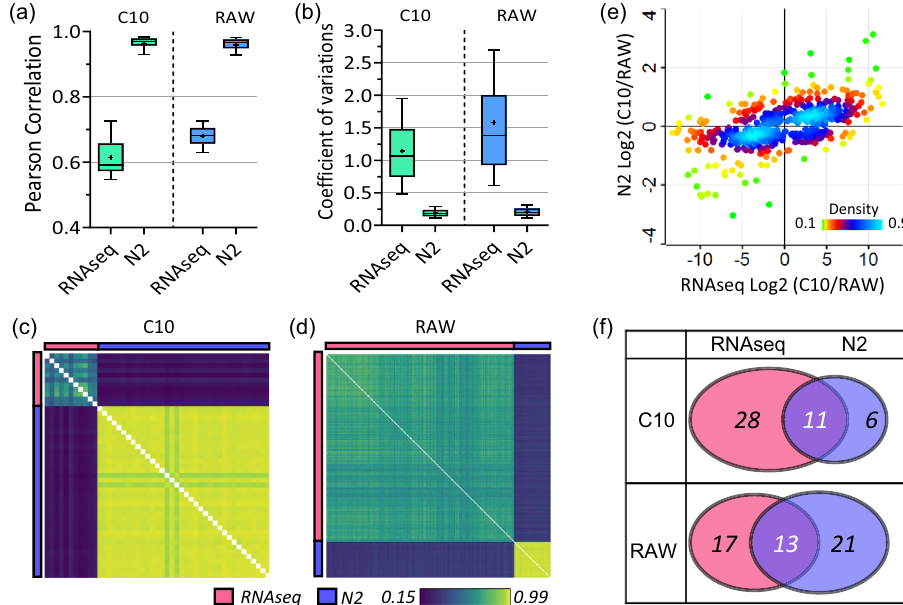
Fig. 6 Integrative analysis of single-cell proteomics and single-cell transcriptomics datasets. a Box plots showing the distributions of Pearson correlation coef fi cients and b coef fi cient of variations of transcript and protein abundances from scRNA-seq (Pearson correlation plot: n = 11 single C10 cells and 186 single RAW cells; coef fi cient of variation plot: n = 1292 genes for both C10 and RAW) and scProteomics (Pearson correlation plot: n = 36 single cells for both C10 and RAW; coef fi cient of variation plot: n = 1292 proteins for both C10 and RAW cells), respectively. Centerlines show the medians; box limits indicate the 25th and 75th percentiles; whiskers extend 1.5 times the interquartile range from the 25th and 75th percentiles. c Clustering matrix showing Pearson correlations of transcript and protein abundances for C10 and d RAW cells. The color scale indicates the range of Pearson correlation coef fi cients. e The linear correlation of log2-transformed fold changes of C10 and RAW cells between scRNA-seq and scProteomics. The color scale indicates the range of data point density. f Venn diagrams showing the overlap of membrane protein markers predicted by RNA seq and proteomics. Source data are provided.